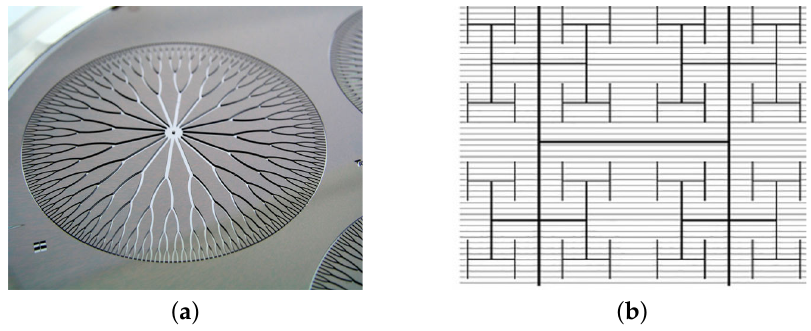
Figure 39. ( a ) Computer chip cooling circuit, ( b ) A fractal solar panel